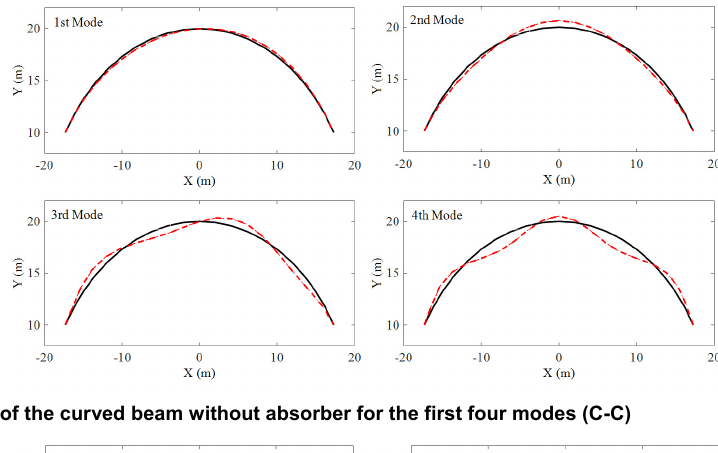
Figure 4. The mode shape of the curved beam without absorber for the first four modes (C-C)